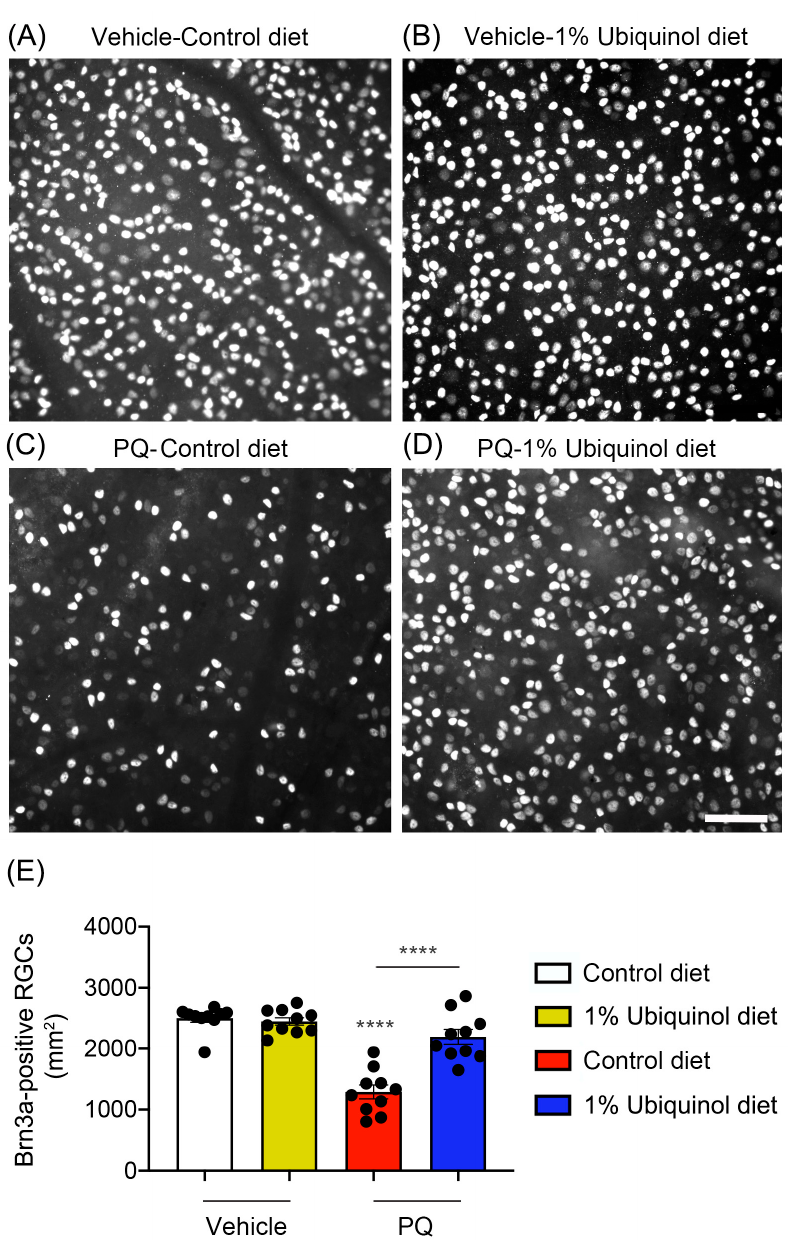
Figure 7. Effect of ubiquinol on RGC survival in PQ-induced C57BL/6J mice. ( A – D ) Retinal whole-mount immunohistochemistry using an antibody raised against Brn3a. Representative images showed Brn3a-positive RGCs in the middle areas of the retinas from each group. ( E ) Quantitative analysis of RGC survival. Data are expressed as mean ± SEM ( n = 5 retinas/group). **** p < 0.0001 (One-way ANOVA with the Bonferroni post hoc test) compared with control C57BL/6J mice supplemented with control diet. Scale bar 100 μ m.